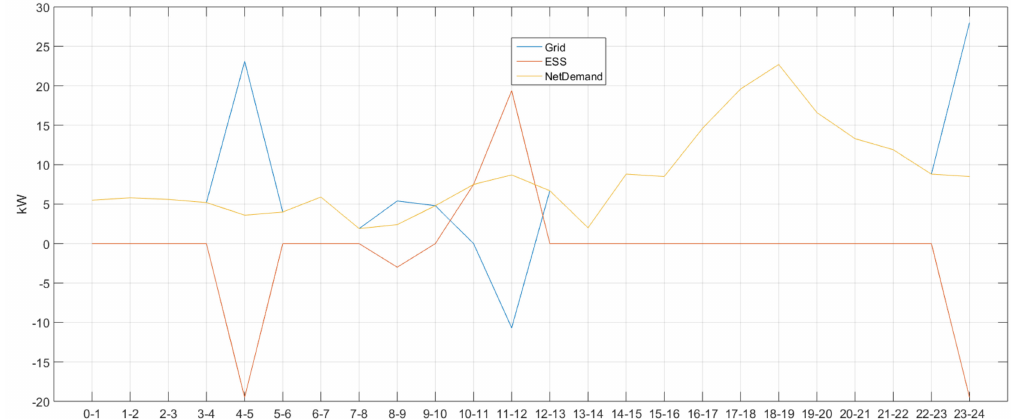
Figure 3. Simulation result when there were no special conditional equations